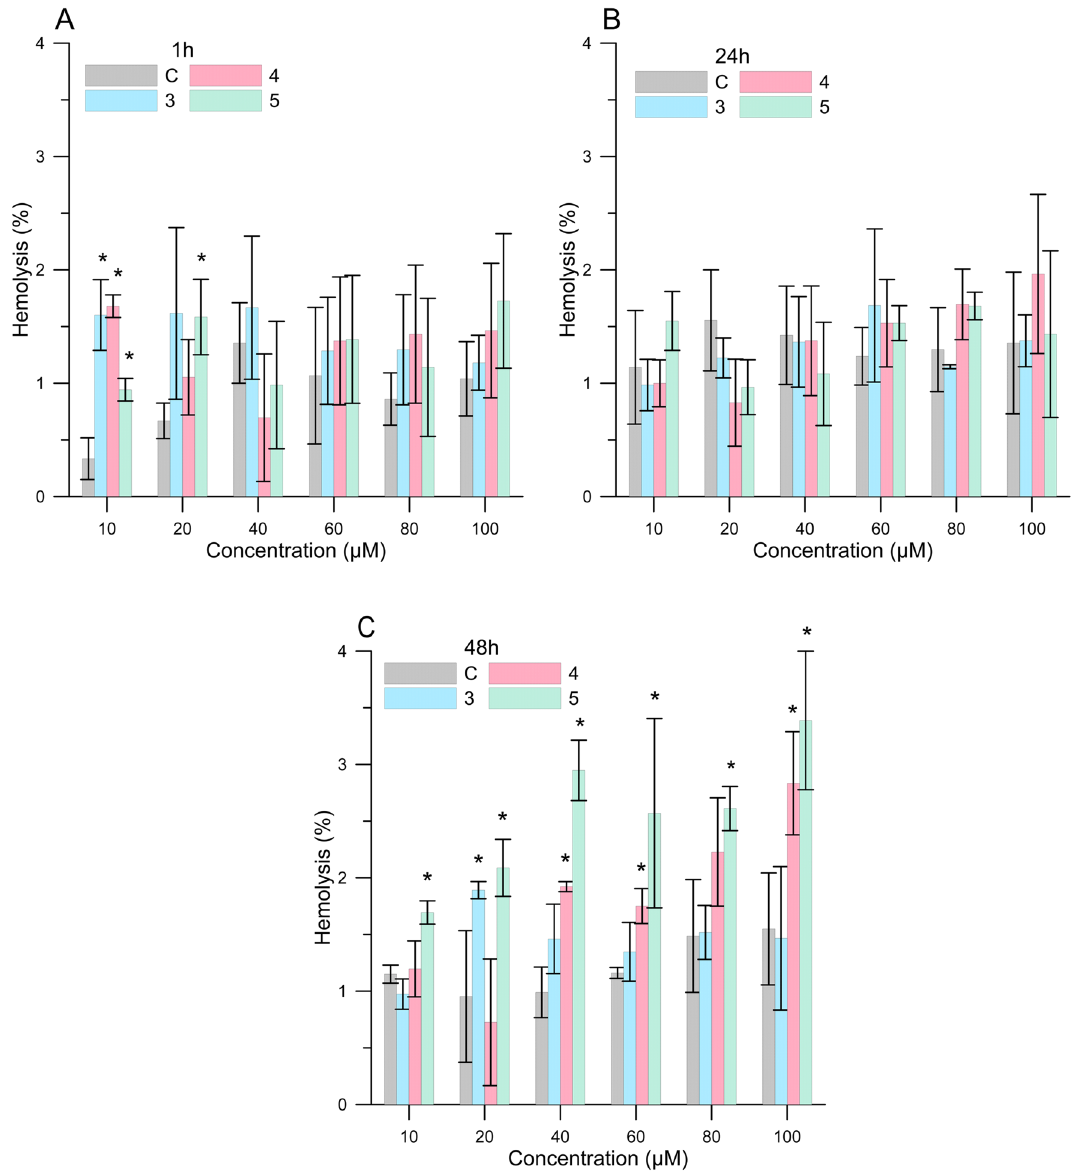
Figure 1. Percentage of hemolysis of RBCs at different concentrations of the compounds (3), (4) and (5) after: ( A ) 1 h, ( B ) 24 h and ( C ) 48 h of